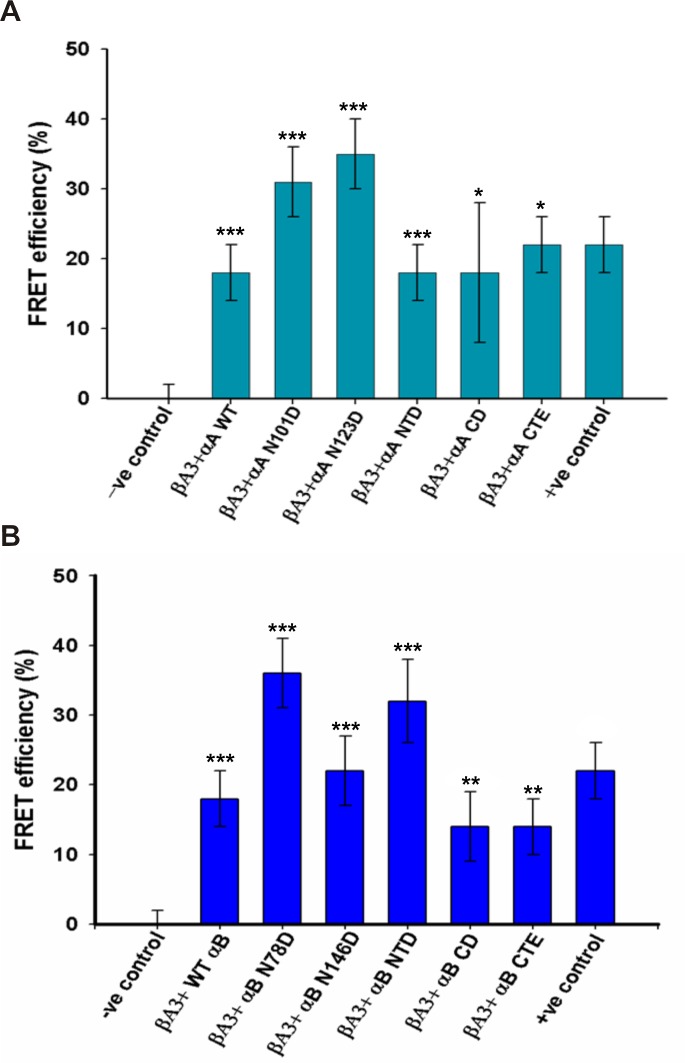
FLIM FRET efficiency of: (A) αA-crystallin (B) WT αB-crystallin, their deamidated and domain mutants.FRET efficiency was calculated from the decrease in life-lime (presented in Fig 8) in 5 to 6 cells. Each experiment was done in triplicate and average FRET efficiencies with standard deviation are presented. For FRET efficiency life-time of donor (TCFP) was 2.8 ns, which was the life-time of CFP βA3-crystallin in negative controls. The results are presented as mean ± standard deviation (SD). The FRET efficiency was significant at the level ***p≤ 0.0001 for WT αA, WT αB and their deamidated mutants, **p≤0.01 for WT αB, CD and CTE and *p≤0.05 for αA CD and CTE domains.